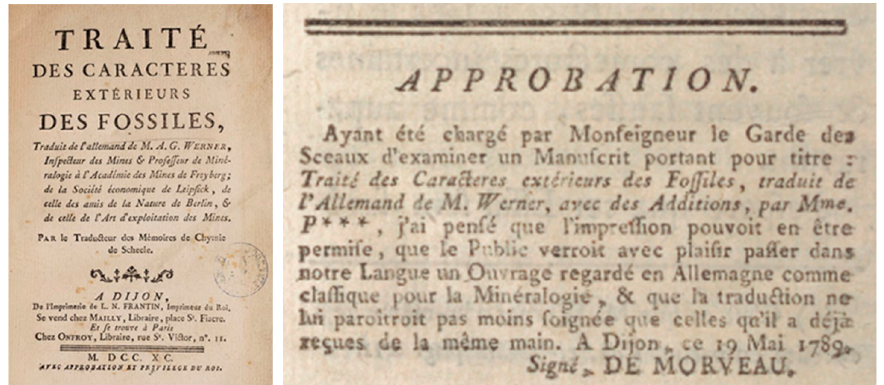
Figure 4. ( Left ) Werner’s Traité translated by Picardet with ( right ) an approval by her future husband that credits her as Mme. P*** [22].